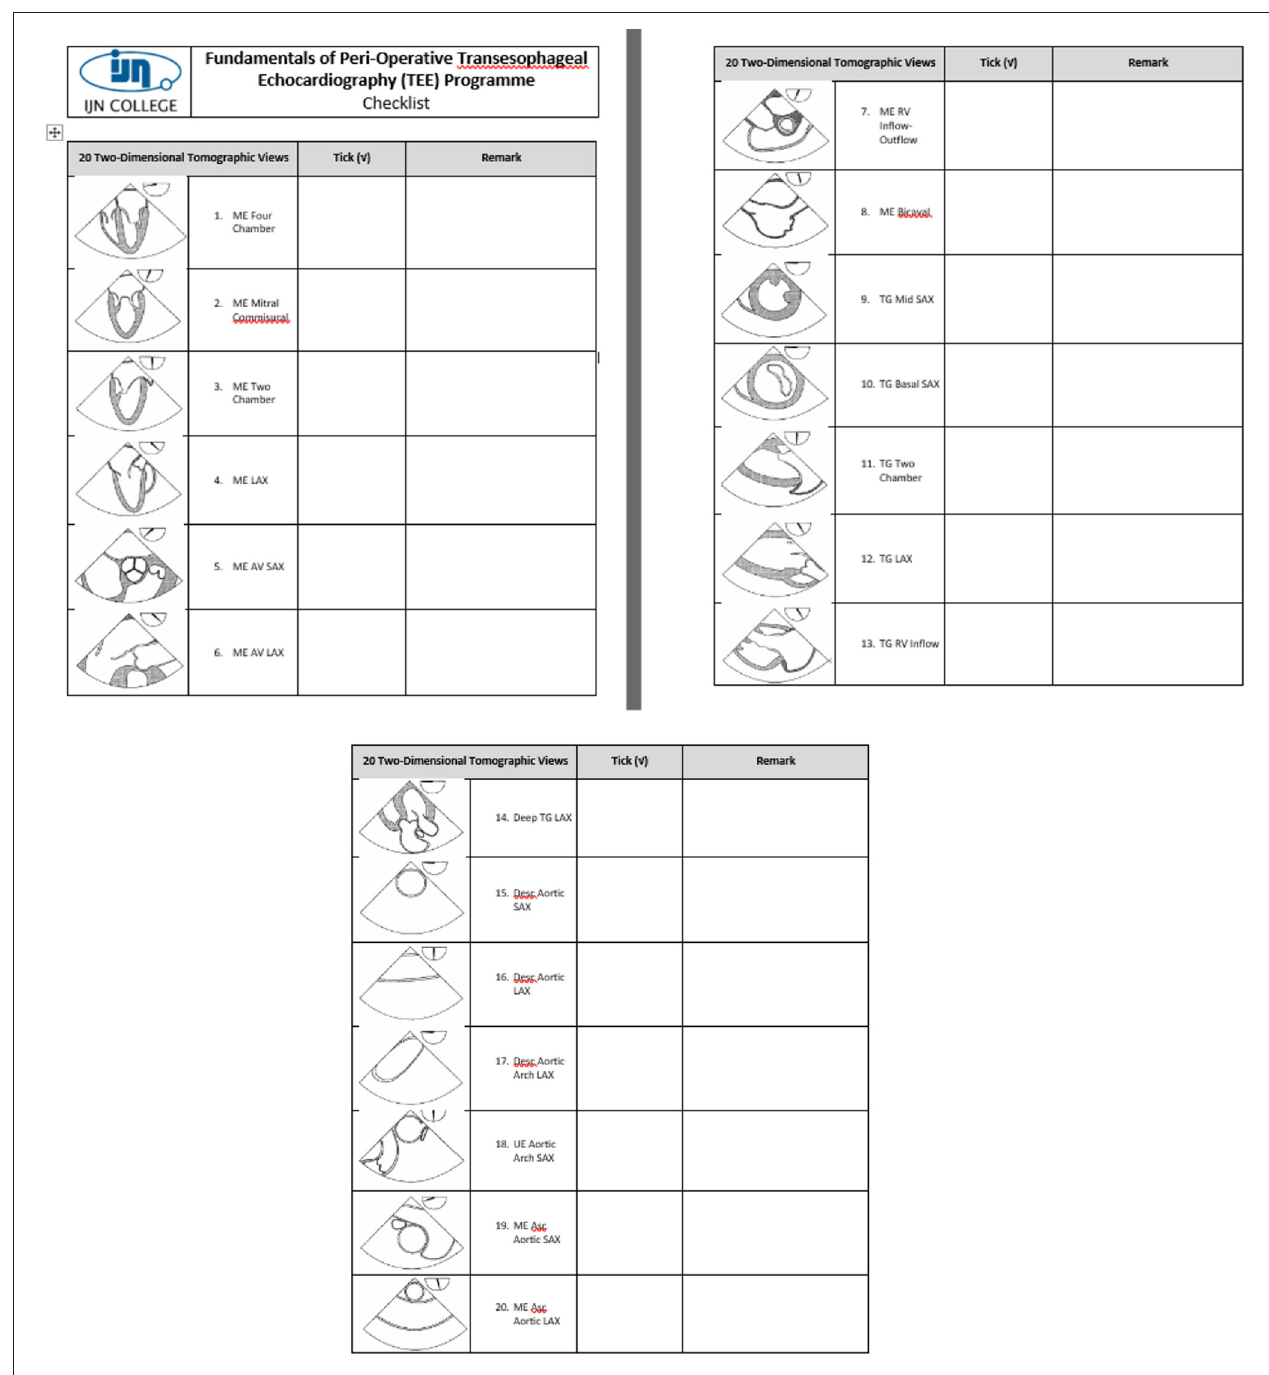
FIGURE 2 | A checklist to guide the image acquisition of the 20 tomographic views in Cohort 2/2012.